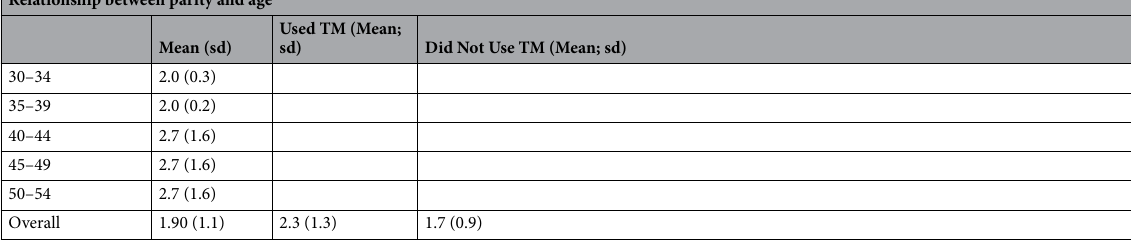
Table 1. Demographic Characteristics of respondents and Traditional Medicine